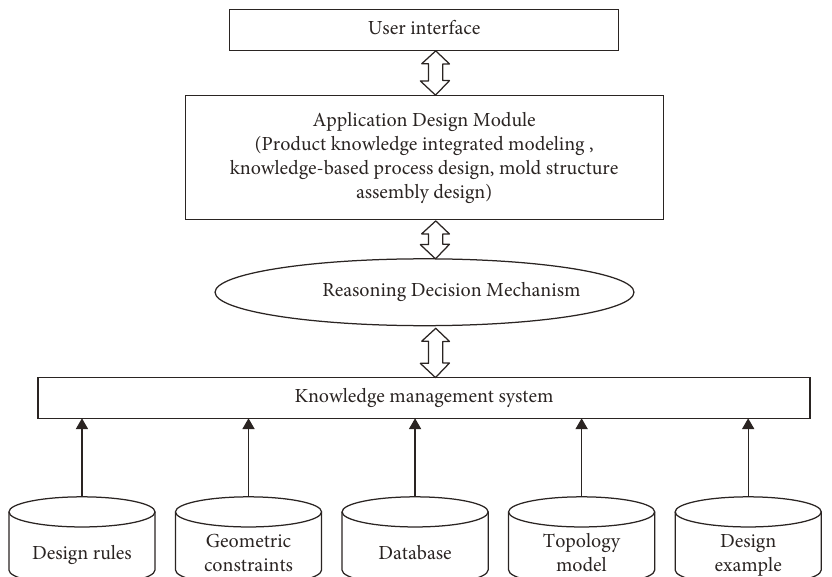
Figure 3: Frame diagram of the cold stamping process of the fuel tank shell and the intelligent design system of the